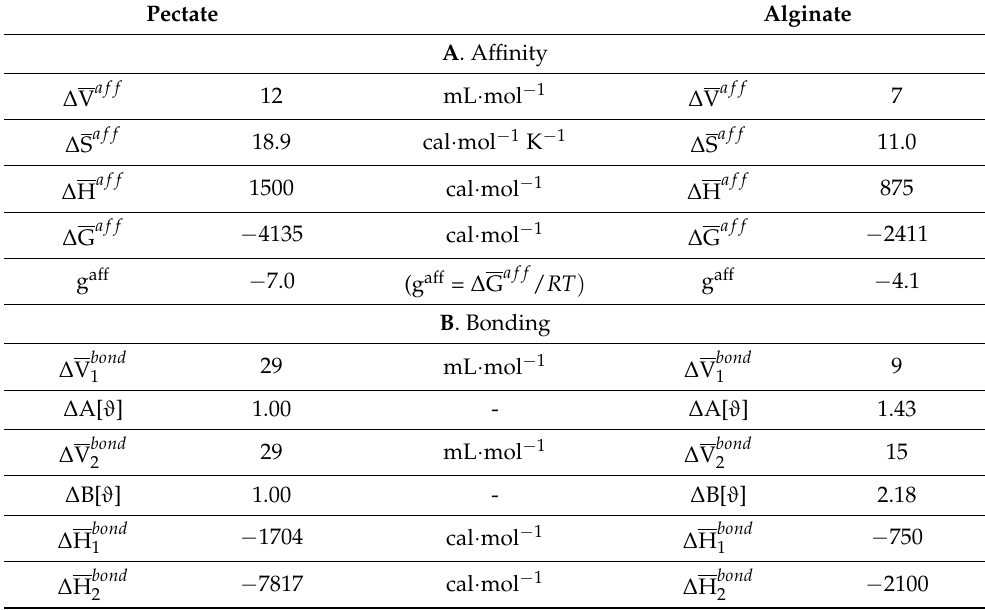
Table 1. Thermodynamic parameters of the affinity (upper part, A.) and of chemical bonding (lower part, B.) interactions of Ca 2+ ions with pectate (l.h.s.) and with L.hyp . alginate